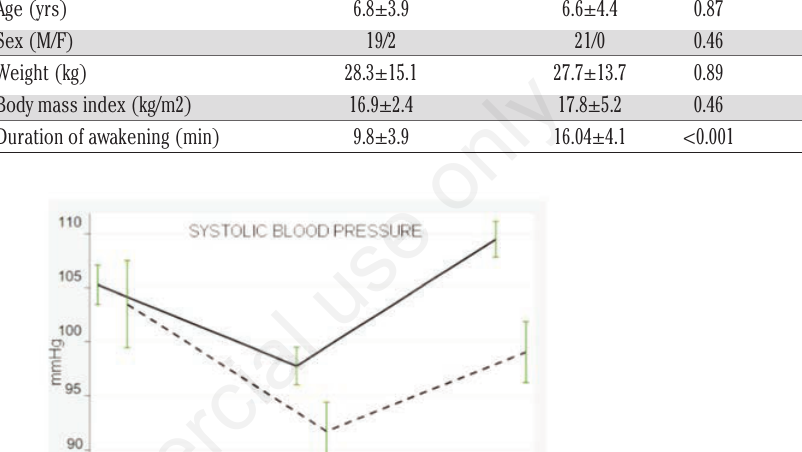
Table 3. Demographic, auxological and procedural characteristics. Characteristics